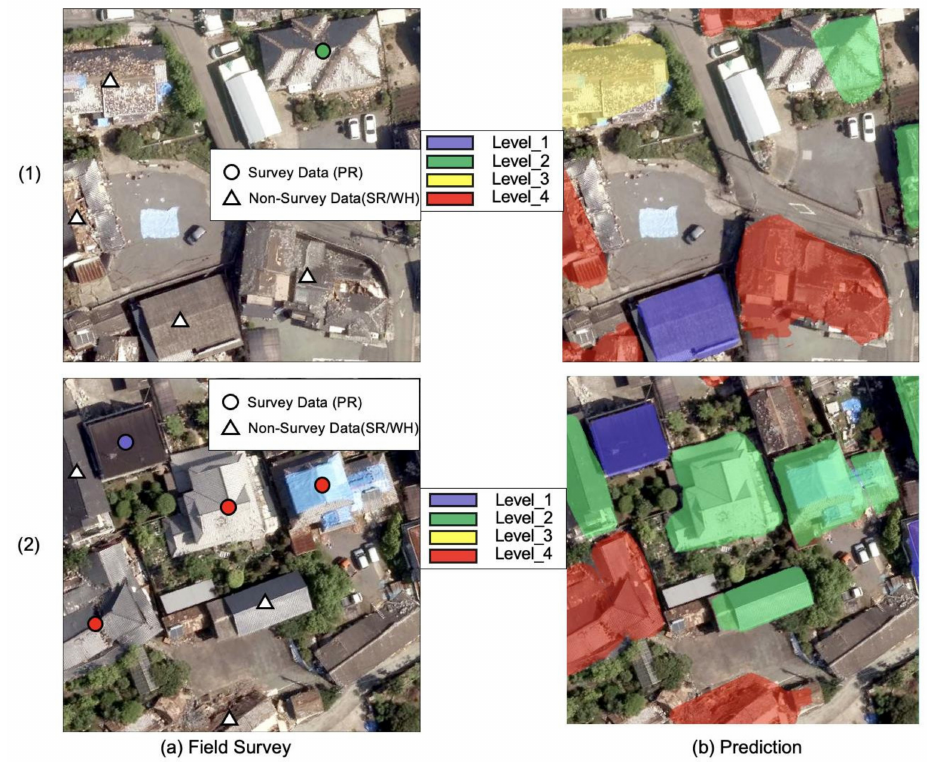
Figure 13. Comparison of the buildings investigated by the AIJ ( a ) and those detected by our proposed model ( b ).